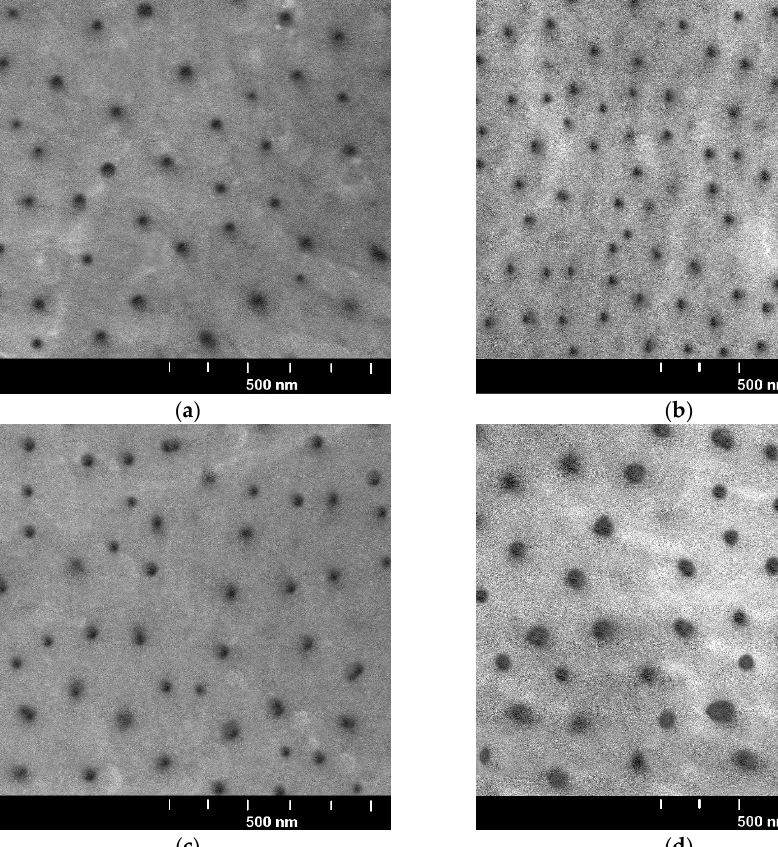
Figure 4. Images of surface morphology of oxide layer: ( a ) sample A, ( b ) sample C, ( c ) sample E, ( d ) sample G.